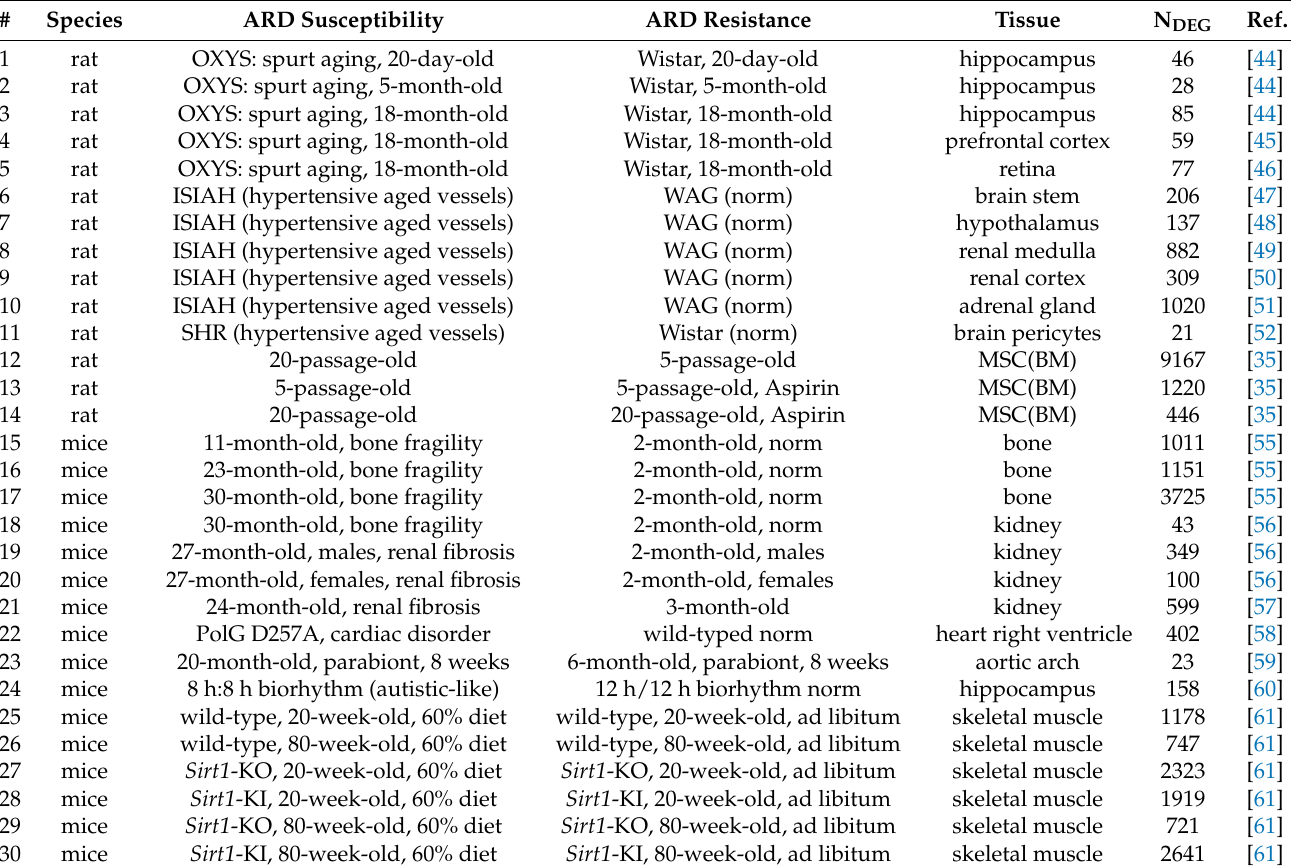
Table 4. Found in PubMed [75]: DEGs in human ARD models based on animal